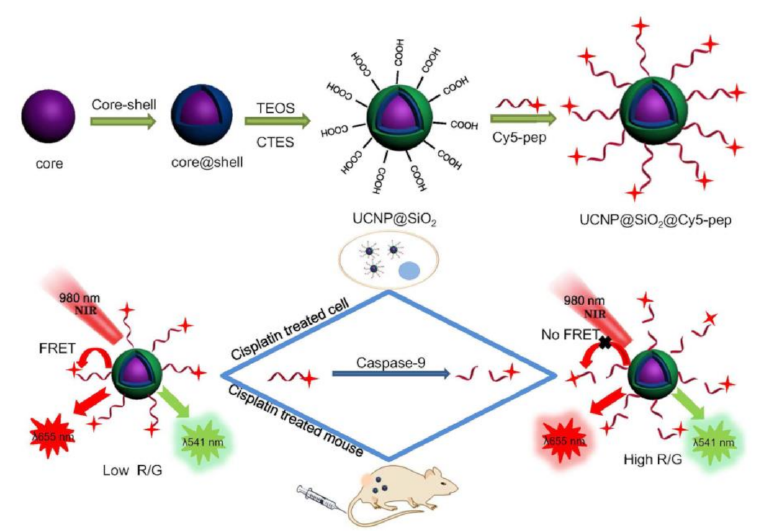
Figure 5. The schematic representation of UCNP-based FRET sensing platform for the detection of caspase-9 activity both in vitro and in vivo by using UCNPs as the energy donor and Cy5 as the energy acceptor. The Cy5 labelled peptide with specific motif LEHD for caspase-9 cleavage were conjugated with carboxyl modified UCNP@SiO 2 through covalent attachment. (Adapted from Liu et al. 2019 [114], Copyright 2019 Elsevier B.V. and reproduced with